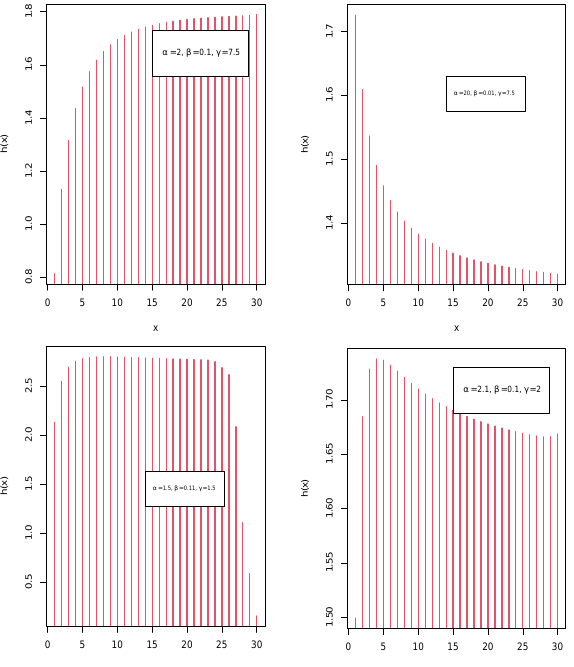
Figure 2. Various shapes of the hazard rate function (hrf) of the LZTBD for different parameter